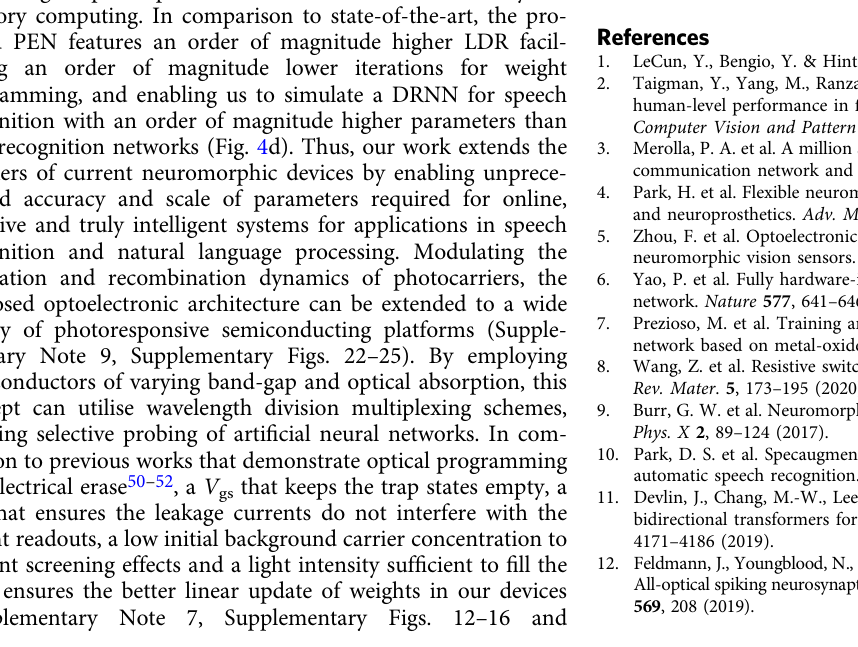
Fig. 4 Simulation of a DRNN for keyword recognition. A deep neural network with 12 trainable layers including convolutional, fully connected, and recurrent LSTM layers is used to classify 12 different spoken digits. a The detailed architecture of the network is shown with all fi lter sizes and dimensions mentioned. b Highly linear weight update of PENs allow us to transfer high precision weights from of fl ine learnt DRNNs (using sophisticated learning schemes with mini-batch averaging for smooth convergence) along with online learning with blind updates for simpler feed-forward networks. c The accuracy obtained in electrical inference with a two-shot opto-electronic write of weights is within 2.5% of the software simulation with fl oating-point numbers. The linear dynamic range of the PEN is limited to ~600 due to the two-shot write scheme. Simulating only one layer of convolution, fully connected or LSTM layers show the recurrent LSTM layers to be most sensitive to low weight dynamic range. d PENs used in our work exhibit an order of magnitude higher linear dynamic range than other recent reports, enabling simulation of DRNNs for speech recognition with an order of magnitude higher weights than other reported simulations for handwritten digit